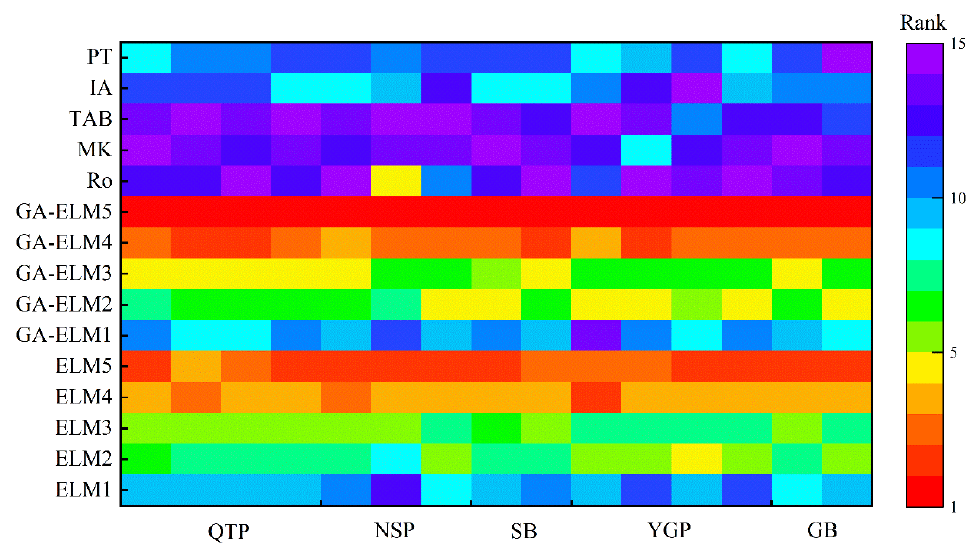
Figure 8. GPI ranking of each model at all stations.